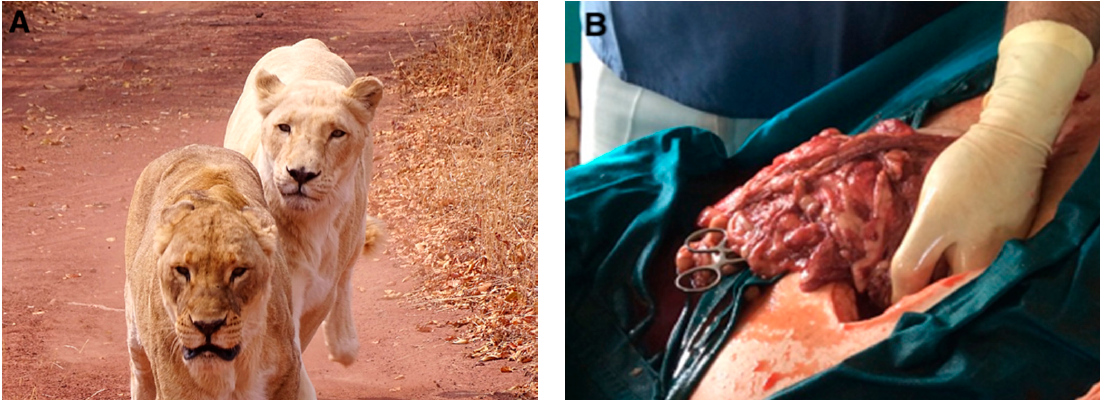
Figure 1. The white lioness with cutaneous melanoma. ( A ) The affected white-coated lioness ( right ), with a healthy normal-coated lioness ( left ). ( B ) Macroscopic photo of the omentum during the exploratory laparotomy.